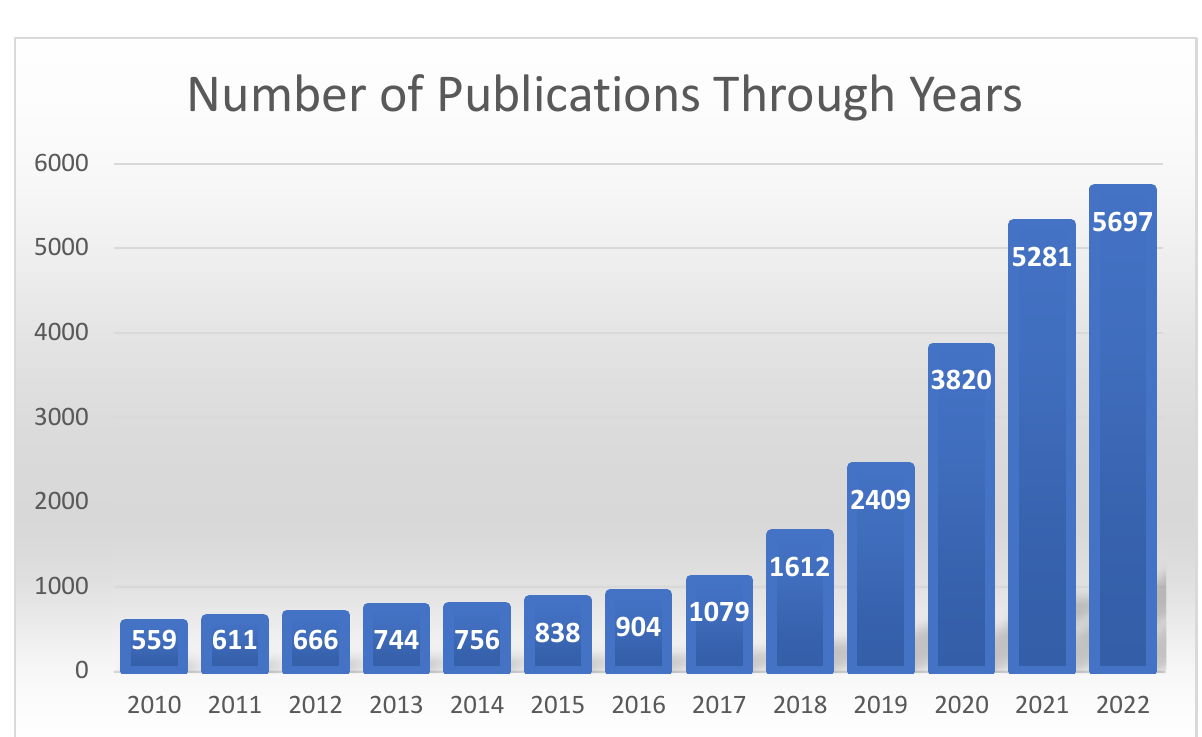
Figure 3. A bar chart showing the number of heart related AI/ML publications on Science Direct, Pubmed and European Heart Journal through years.